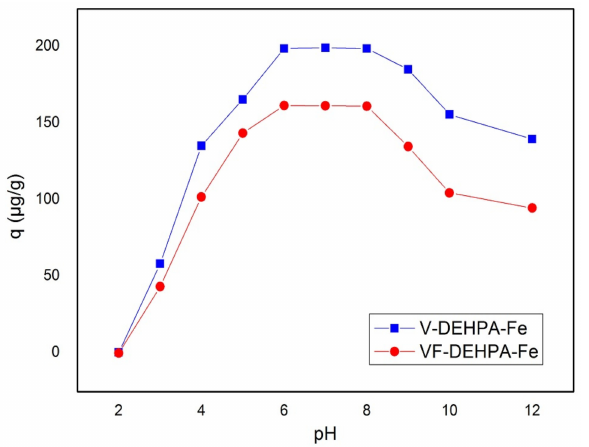
Figure 5. Effect of pH on adsorption capacity of As(V) on functionalized